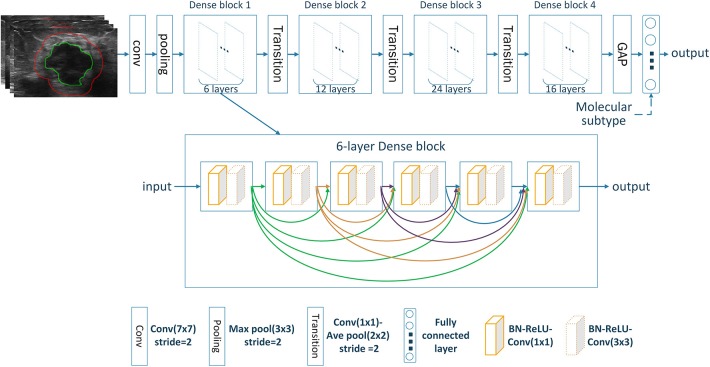
The architecture of the deep CNN used in our study.